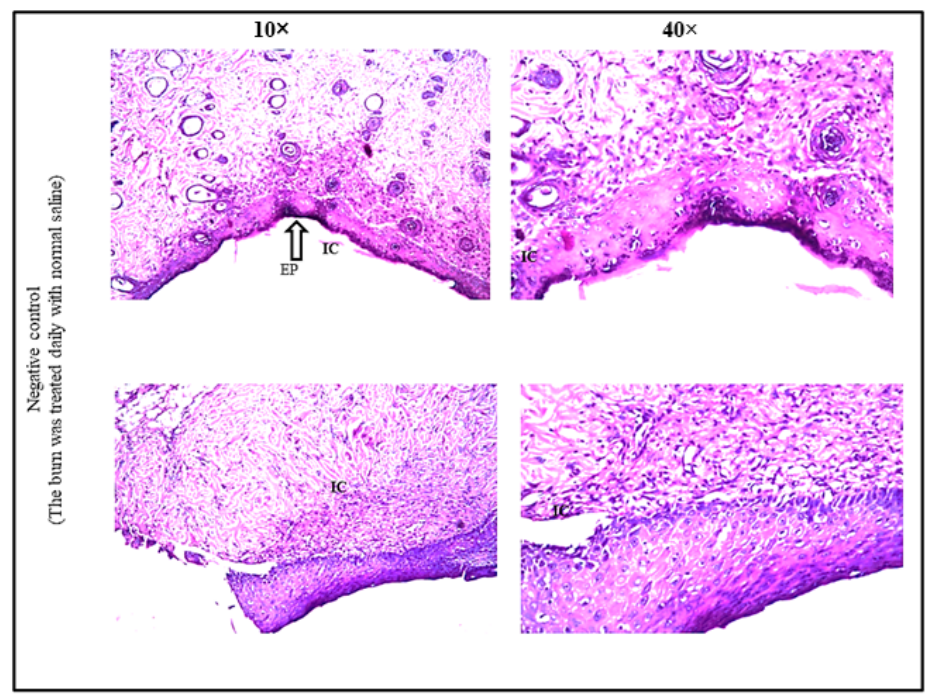
Figure 7. The representative photomicrographs of burned areas from two different rats of negative control group (treated daily with normal saline) stained with hematoxyline eosin on the seventh day of burn induction. Photomicrographs were taken at a magnification of 10× and 40×. Ep, epidermis; IC, inflammatory cells. Table 3. Semi-quantitative assessment of pathological changes in different groups.